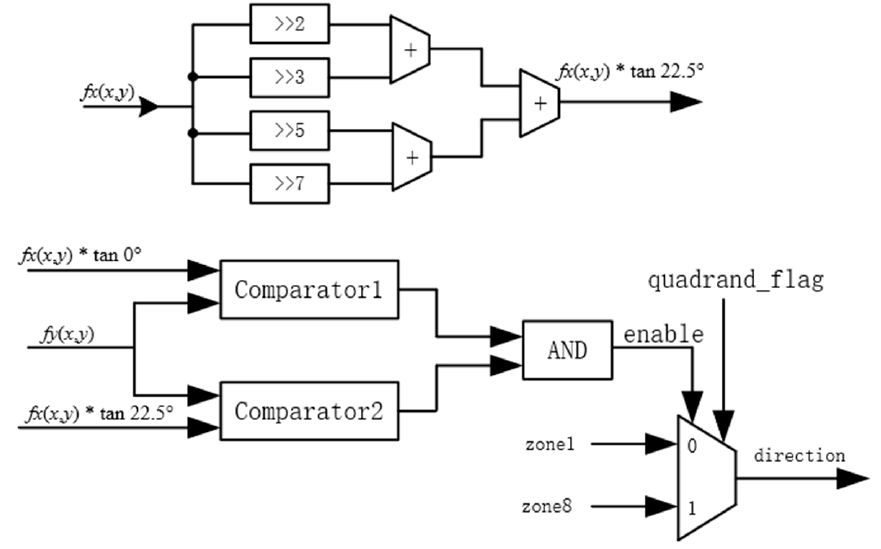
Figure 8. Architecture to find the direction.